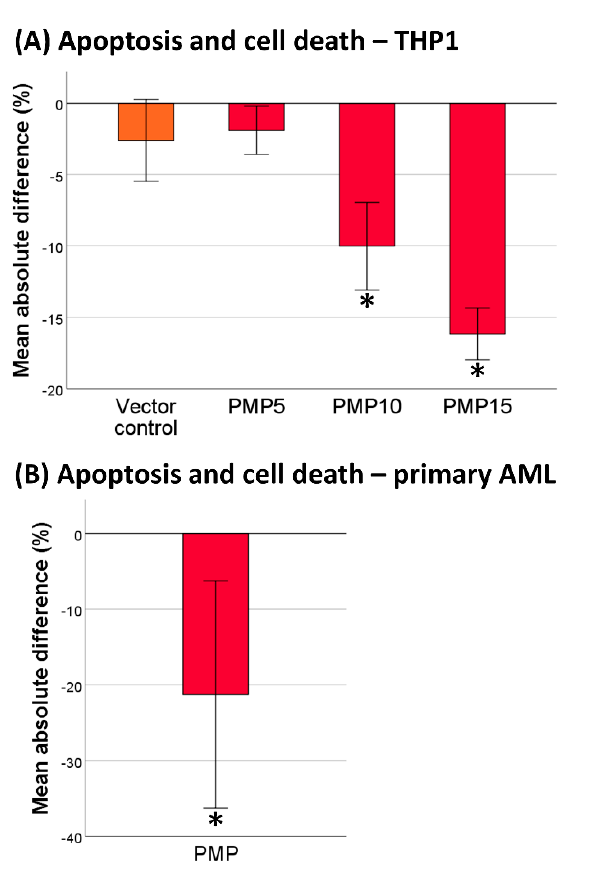
Figure 2. Apoptosis and cell death in THP-1 and primary acute myelogenous leukemia (AML) cells treated with 0.5 µM daunorubicin. ( A ) Difference in frequency of dead and apoptotic cells in THP-1 cells with or without co-incubation with platelet microparticles (PMPs) ( n = 3). Number following different PMP groups denotes final concentration in million PMPs per mL medium. ( B ) Evaluation of the effect of PMPs on the frequency of dead and apoptotic cells in primary AML cells (nine patient samples, n = 4). p values were calculated using the one-sample t test (test value = 0). * p < 0.05.